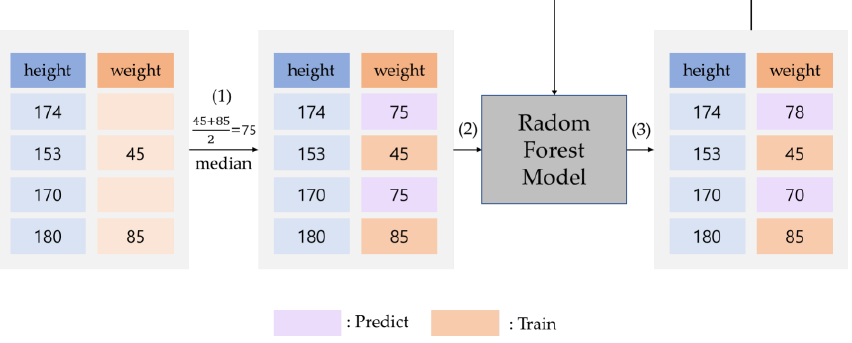
Figure 3. Processing by the MissForest. (1) Interpolate missing values into the median. (2) Train via dataset. (3) Interpolate missing values into the prediction results.